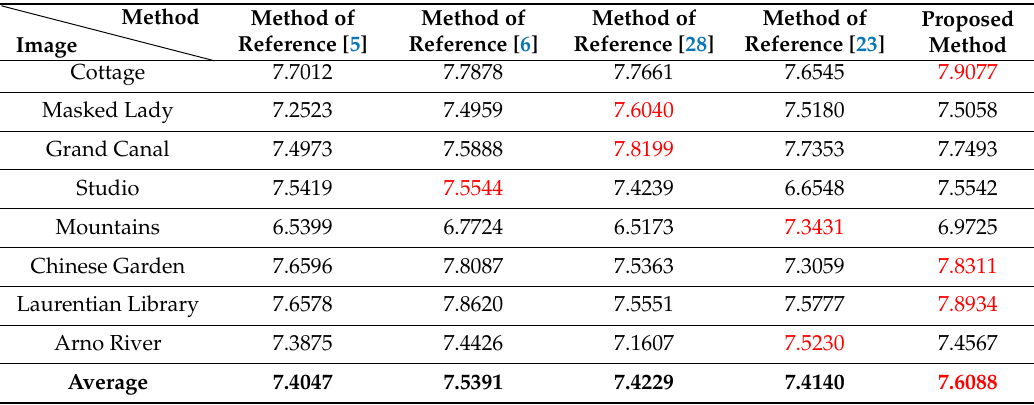
Table 3. Comparison of the five methods in terms of image entropy.